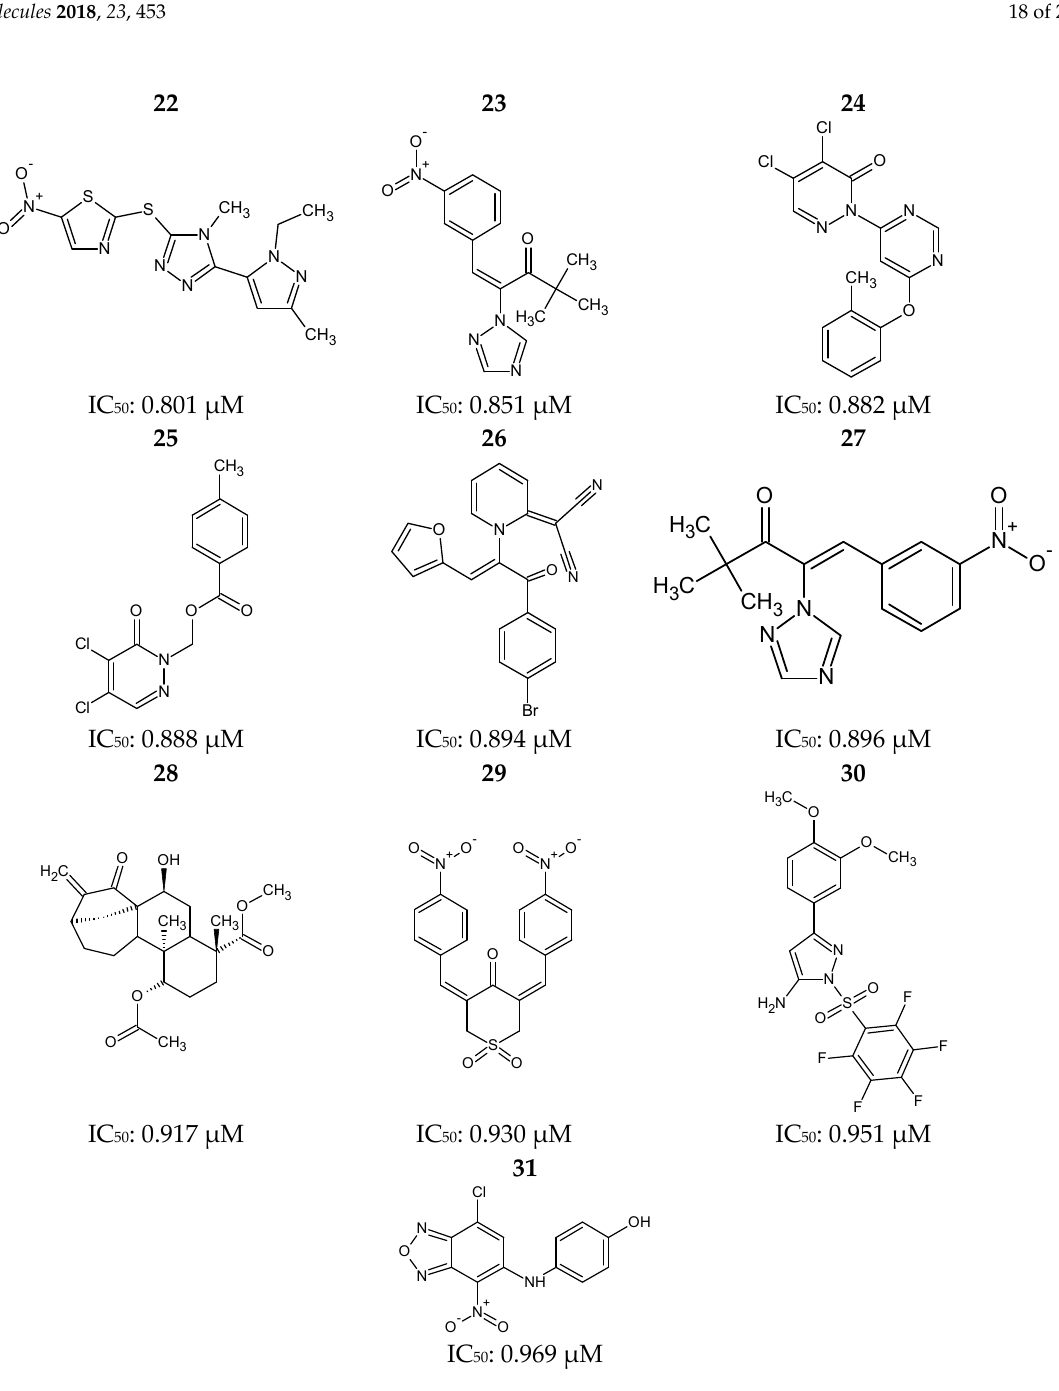
Figure 12. Ponatinib ( 1 ) and 30 most potent RIPK2 inhibitors ( 2 – 31 ) obtained from the Protein Data Bank (PDB) and the BindingDB database. Bank (PDB) and the BindingDB